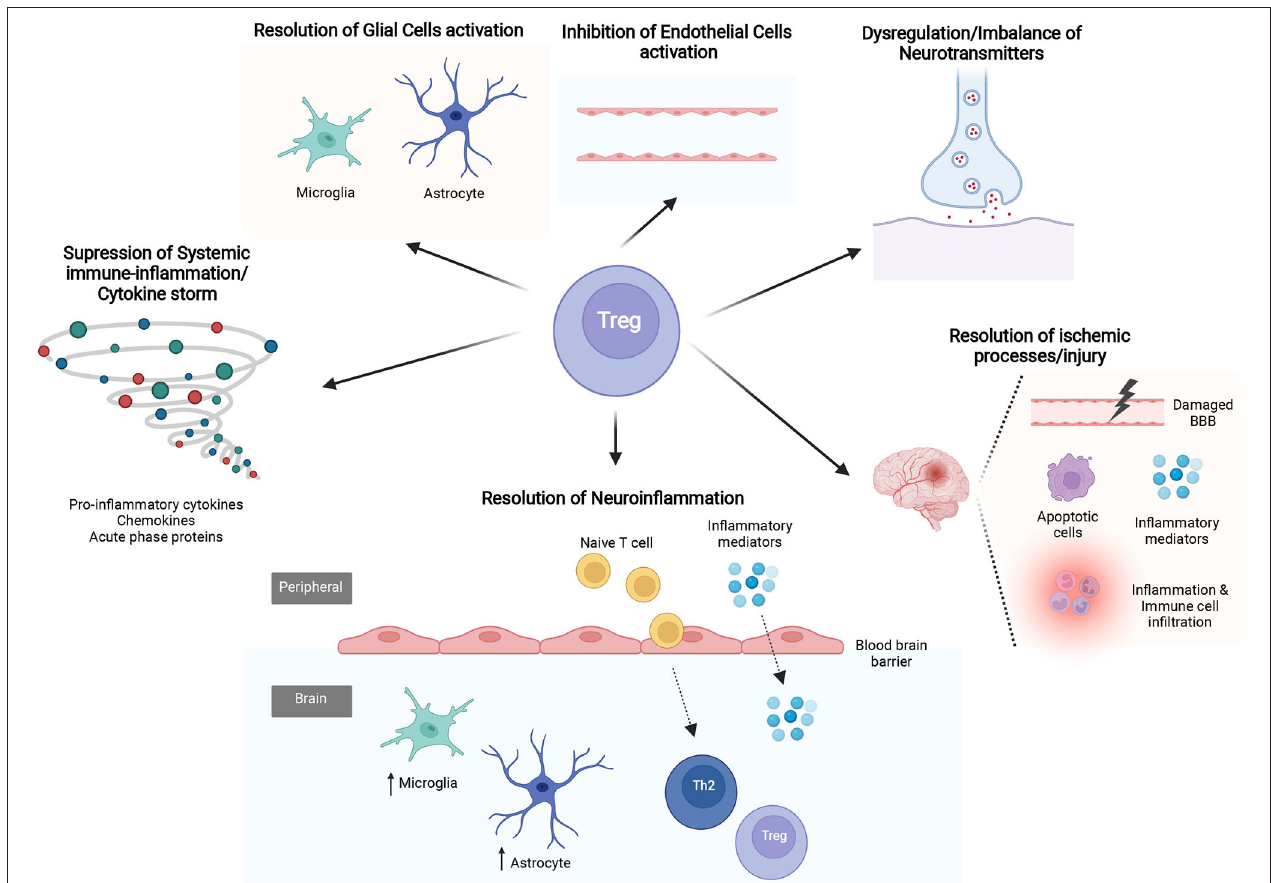
FIGURE 3 | The mechanisms of Regulatory T cells (T regs ) in sepsis-associated encephalopathy (SAE). Several studies evidence the mechanisms by which T regs may affect different processes know to be related with SAE pathophysiology. The latter include suppression of systemic immune-inflammation/cytokine storm, resolution of excessive neuroinflammation and ischemic processes/injury, regulate the imbalance of neurotransmitters and regulation of glial cells and cerebral endothelial cells (CECs)